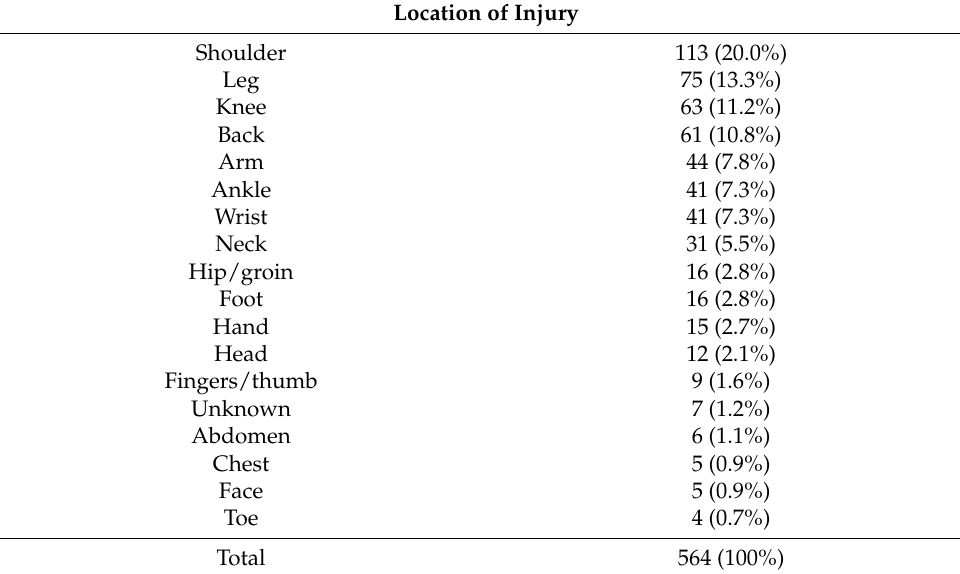
Table 3. Body sites of injures in the NZ Police Force. Reported as number of injuries